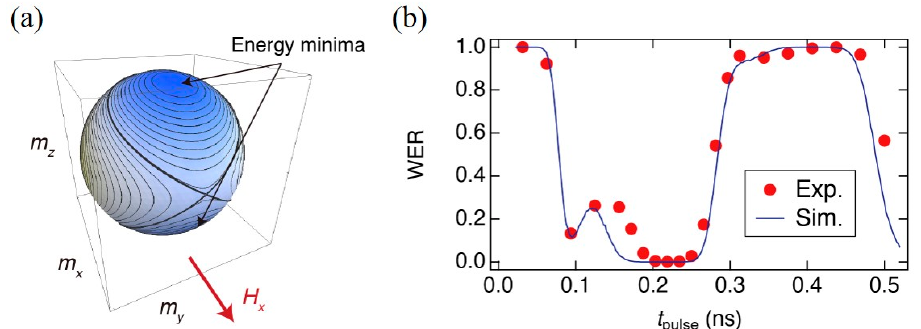
Figure 19. ( a ) Contour plot of energy density in the absence of a bias voltage. ( b ) Appearance of a local peak in the WER observed in an MTJ consisting of Ta / (Co 30 Fe 70 ) 80 B 20 (1.1 nm) / MgO / reference layer. The filled circles and the lines represent experimental data and numerical simulations, respectively. Reprinted figure with permission from [107], Copyright 2018 by the American Physical Society.